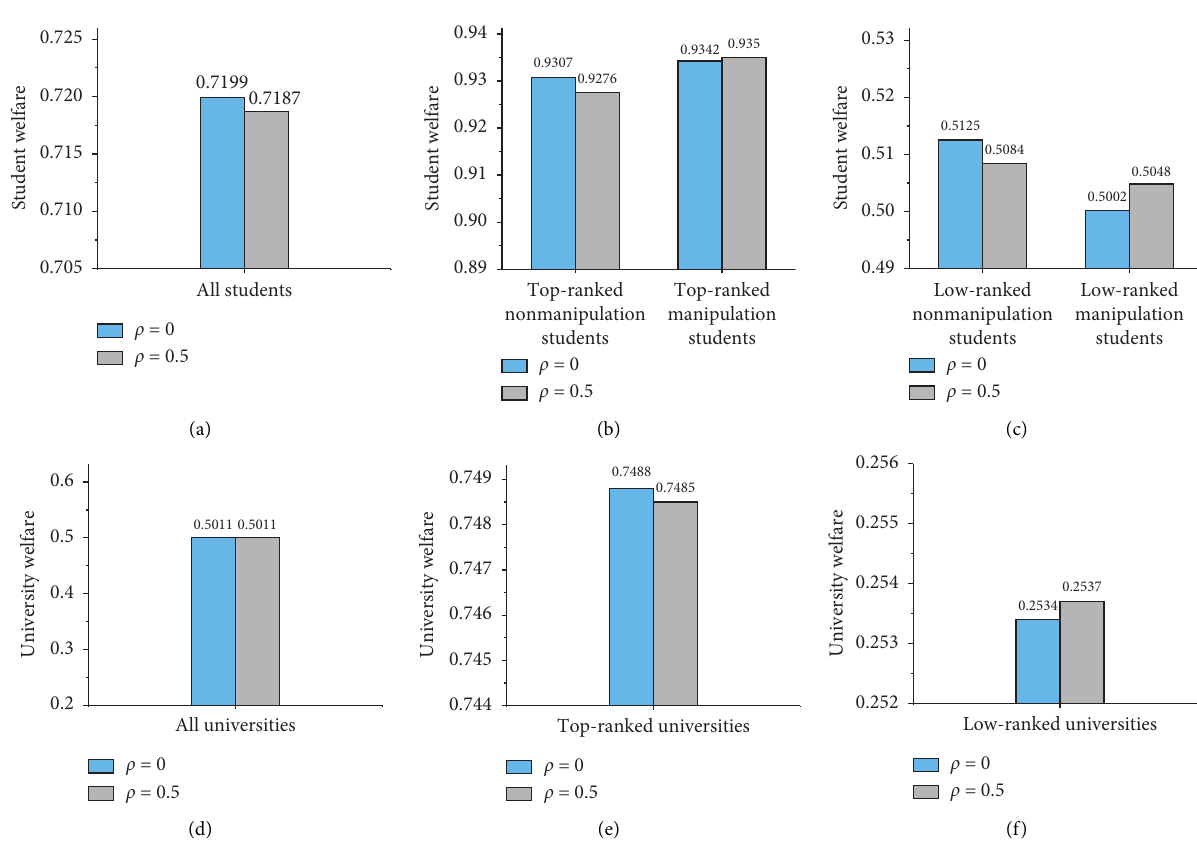
Figure 3: Student welfare and university welfare under the state with no manipulation ( ρ � 0) and under the steady state with manipulation ( ρ � 0.5). The top-ranked and low-ranked students are those whose scores are ranging from 625 to 700 and 500 to 624. The top-ranked and low-ranked universities are No. 1–15 and No. 16–30 universities in the public ranking,